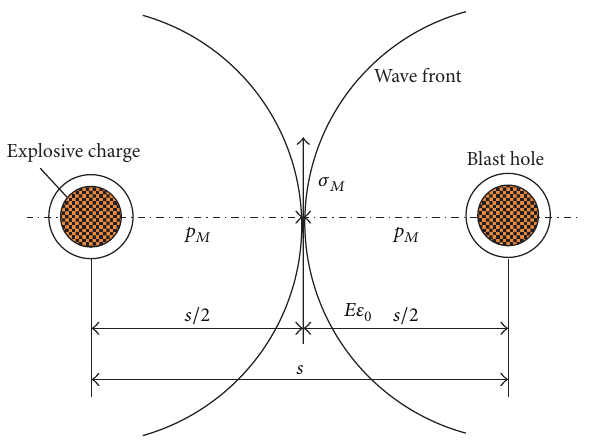
Figure 4: Wave front of two adjacent blast